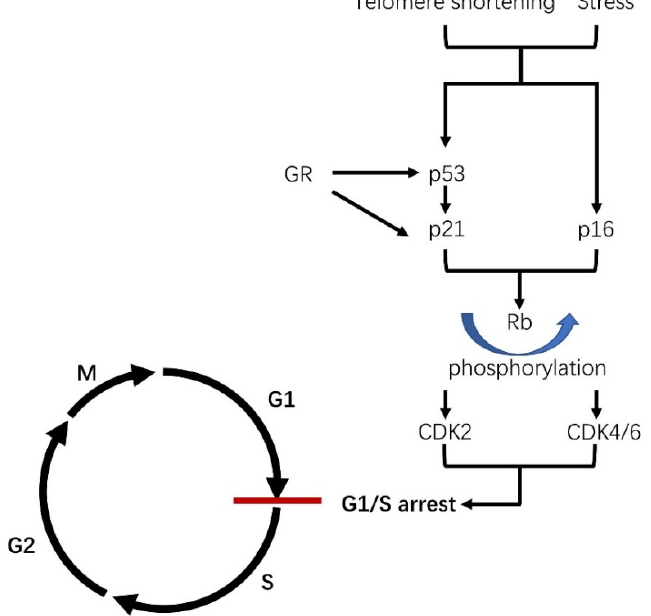
Figure 1. The molecular pathway of cellular senescence. The infinite cell division and stressful stim- uli can finally induce a replicative senescence and stress-induced senescence, respectively. Both of those two factors activate the transcription of p53 through a DNA damage response (DDR) which subsequently stimulates that of p21. On the other hand, telomere shortening and stress can also initiate the transcription of p16. Both activation of p16 and p21 then induces the phosphorylation of the retinoblastoma (Rb) protein which induces an increased expression of cyclin-dependent kinase 2 (CDK2) or CDK4/6 resulting in cell cycle arrest of the G1/S phase. Adrenocortical steroids, such as aldosterone, cortisol and adrenal androgen, were recently reported to induce cellular senescence. Cortisol can bind to glucocorticoid receptors (GR) leading to an increase in p53 transcription under the involvement of glucocorticoid response elements (GRE) [30]. GR can also mediate p21 transcription in a p53-inpendent manner though GRE or a CCAAT/enhancer binding protein (C/EBP) [30,31]. However, the mechanisms of aldosterone and adrenal androgen in the development of cellular se-